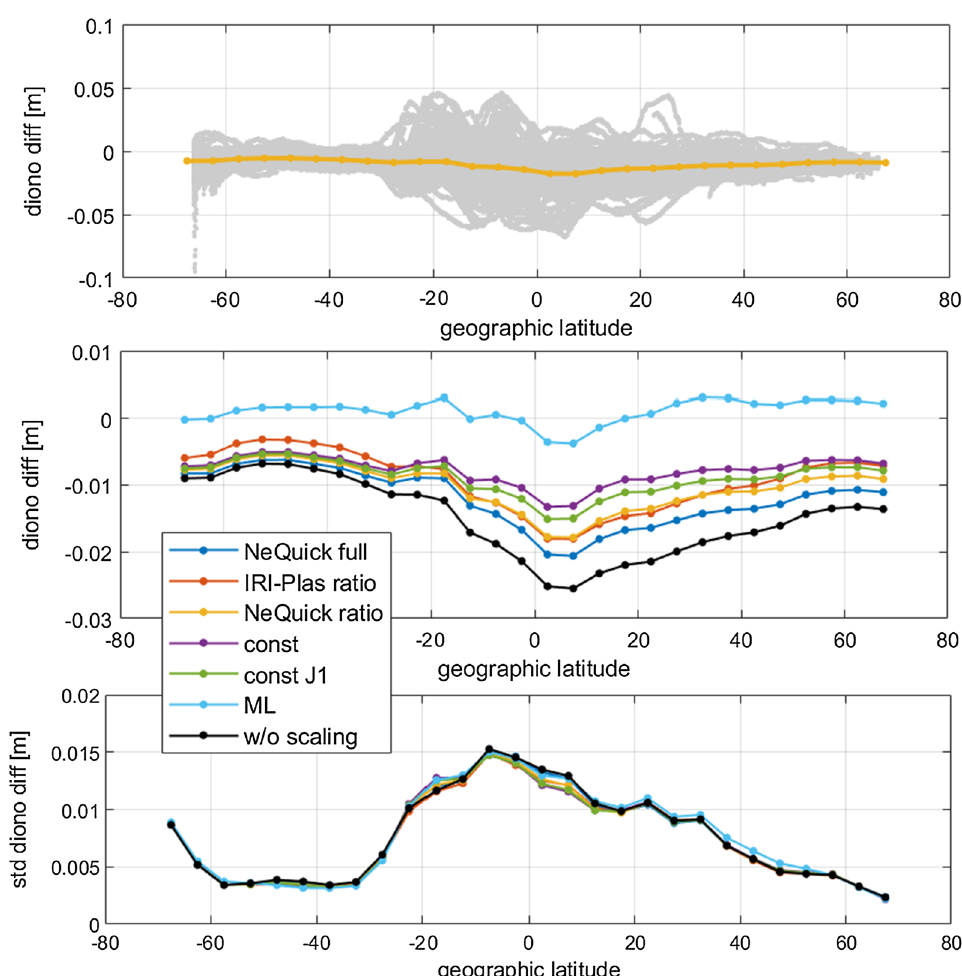
Fig. 3 Differences (diff) in ionospheric corrections (diono) with respect to smoothed dual-frequency correction for Jason-1 Cycle 015 (June 2002). Top plot shows the differences from the solution scaled with NeQuick ratio (3) in grey and the median for 5-degree latitude classes. The middle plot shows the median differences for all seven solutions and the bottom plot the respective standard deviation (std) per latitude